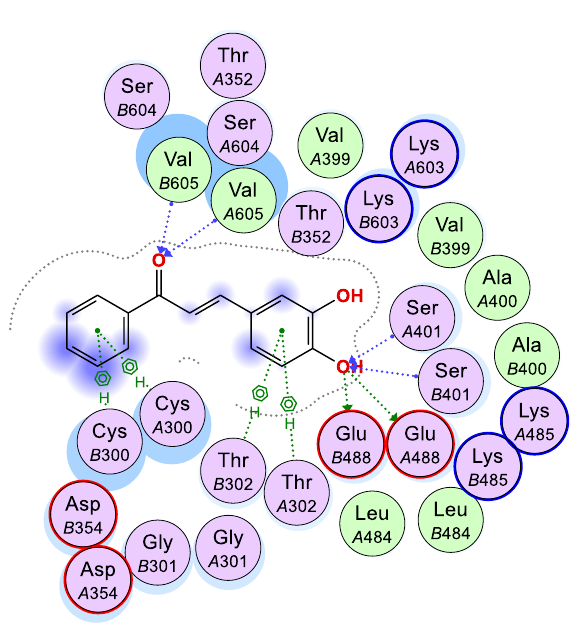
Figure 4. 2D representation of the binding interactions between compound 6g and the amino residues of